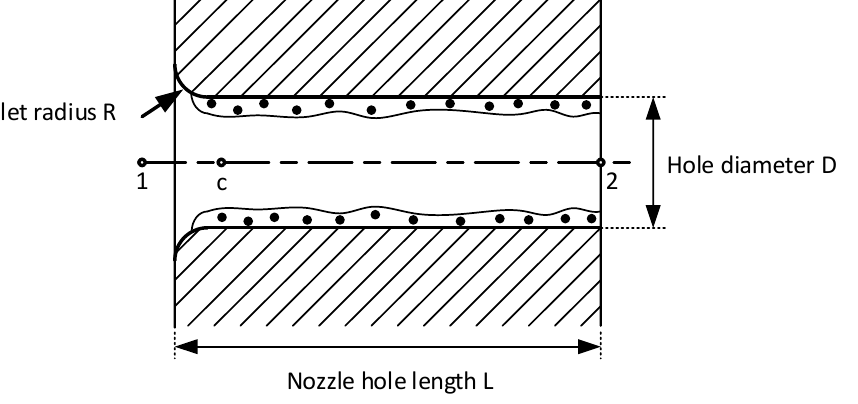
Figure A1. Principal schematic of the direct-injection diesel